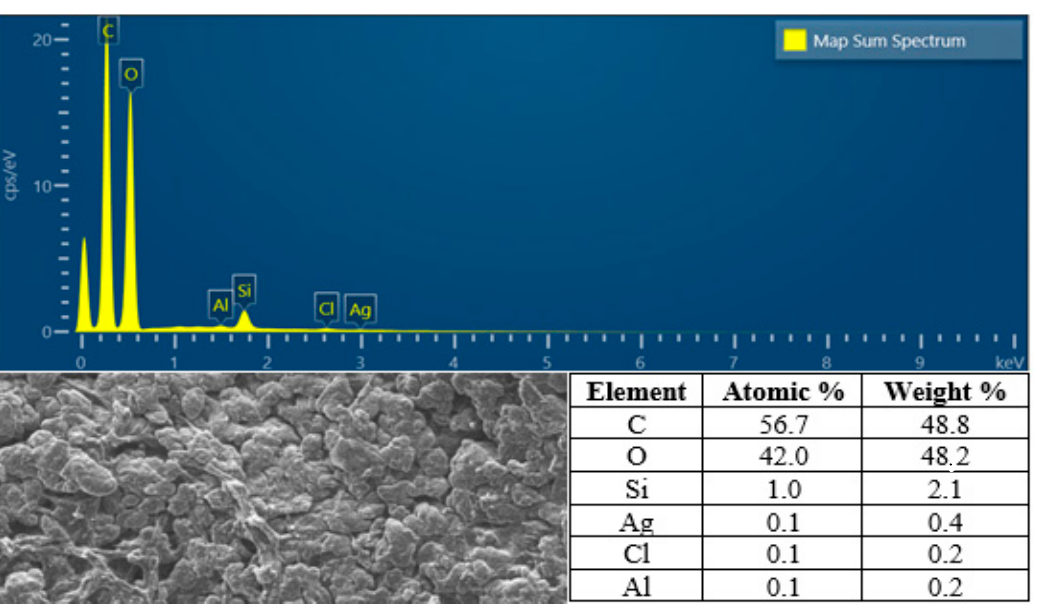
Figure 11. The SEM-EDX analysis of F 1